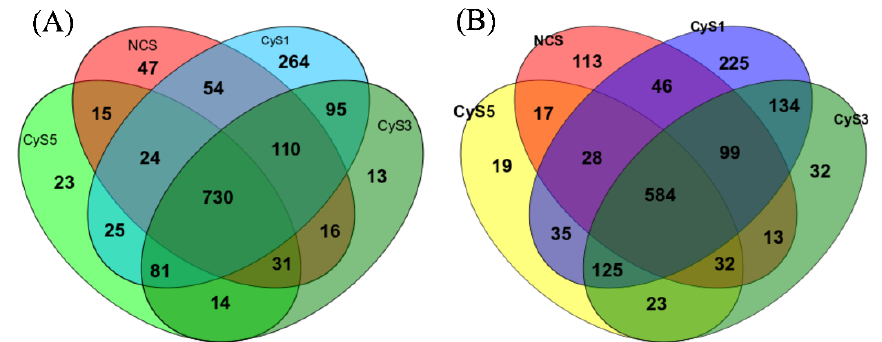
Figure 1. Venn diagrams of unique species of bacteria in the soils from 4 time ‐ series C. chinensis fields in winter ( A ) and summer ( B ). NCS, fallow field soil; CyS1, one ‐ year C. chinensis cultivated soil; CyS3, three ‐ year C. chinensis cultivated soil; CyS5, five ‐ year C. chinensis cultivated soil.